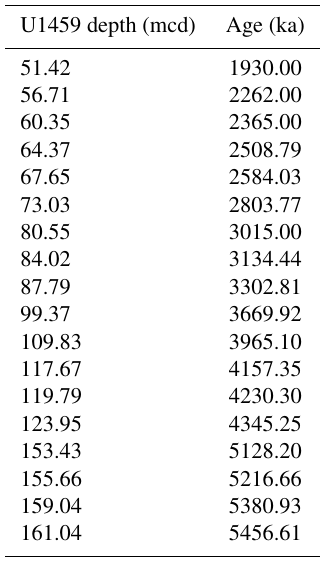
Table A1. Age–depth model for the Plio-Pleistocene interval of